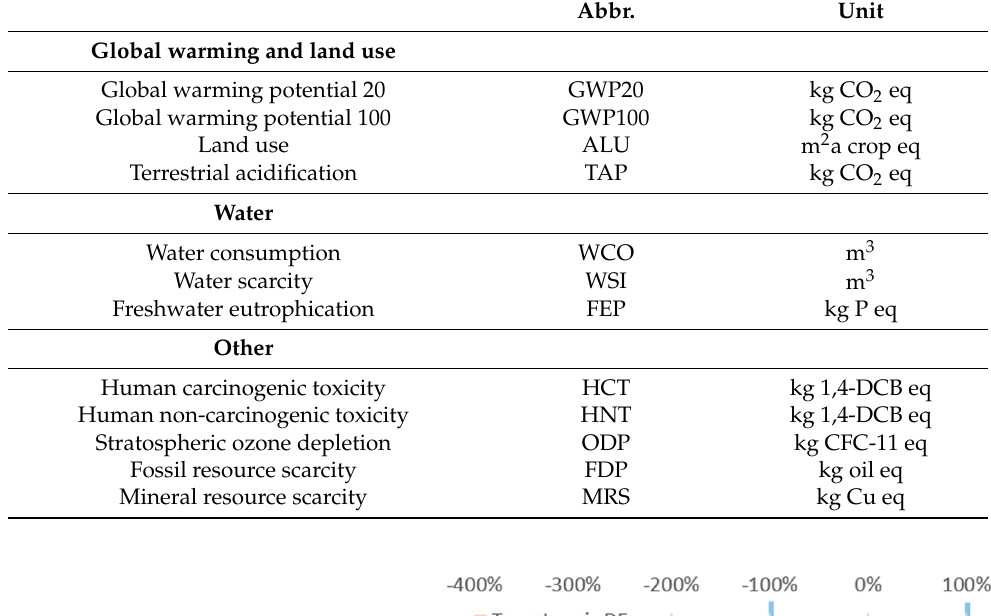
Table 1. Grouped LCA impact categories; author’s work based on comparative-LCA [41].